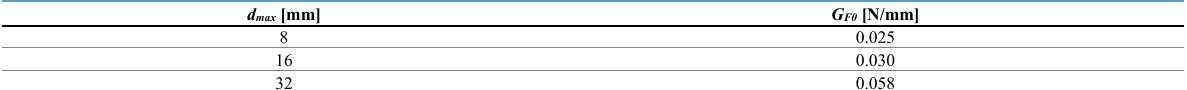
Table 4. Reference value of fracture energy as a function of aggregate size by CEB/FIP Model Code [34]. d max [mm]